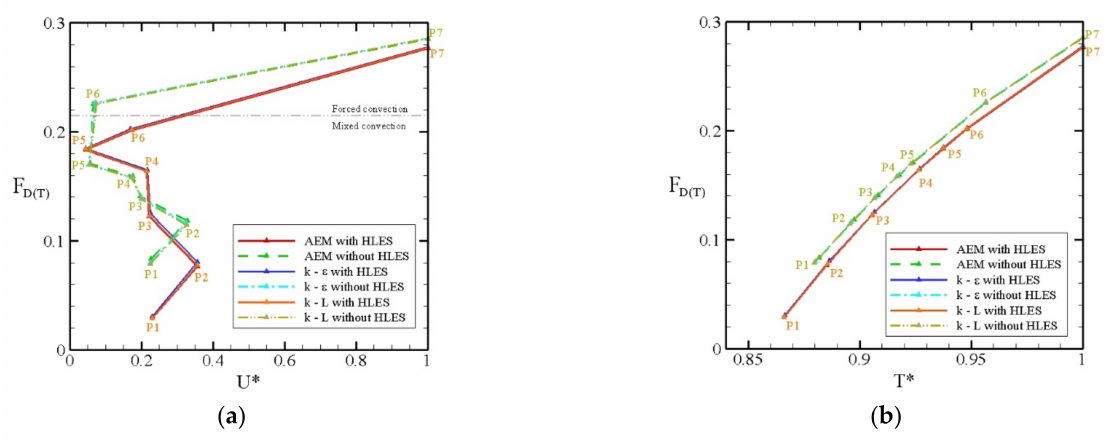
Figure 14. Behavior of the dimensionless parameter F D ( T ) computed at the free surface for the different turbulence closure models considered: ( a ) F D ( T ) vs. U ∗ ; ( b ) F D ( T ) vs. T ∗